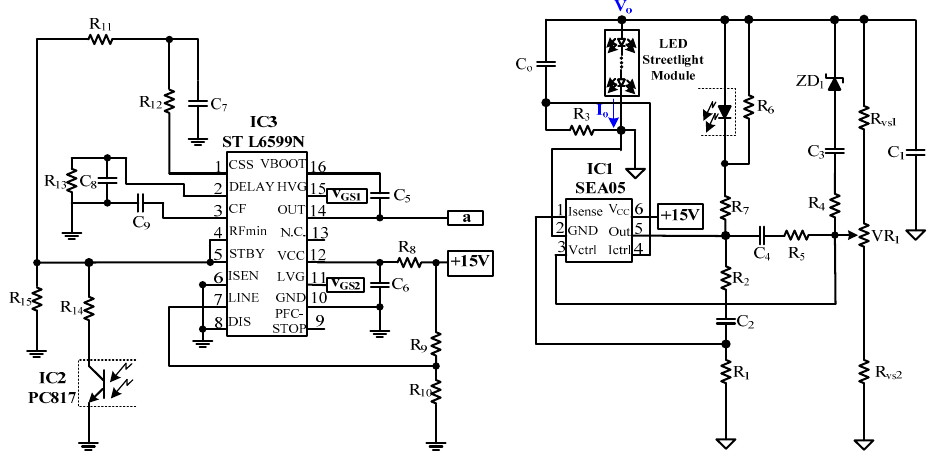
Figure 3. The utilized control circuit of the presented single-stage LED driver for streetlight applications.